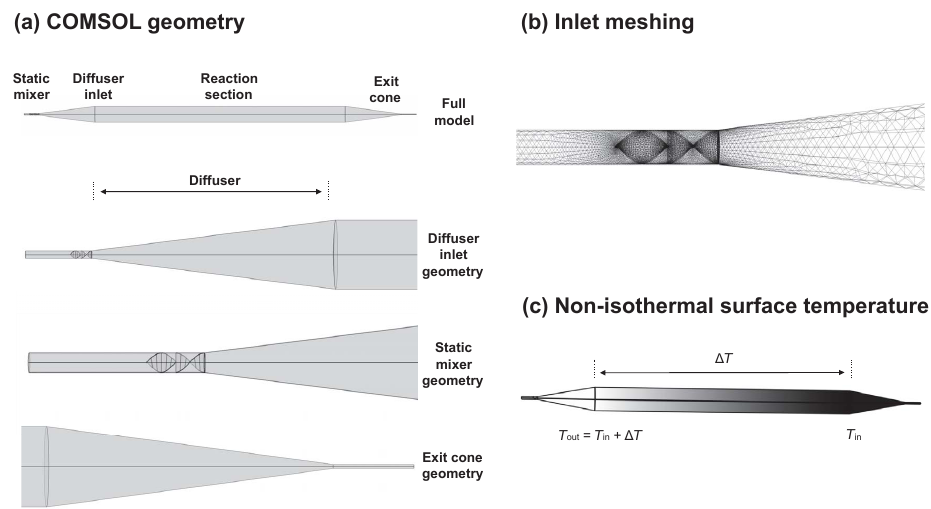
Figure 3. (a) Overview of the geometry used to simulate flow and species transport within the CPOT. (b) Inlet meshing for static mixer. (c) Schematic illustration of the temperature gradient used in non-isothermal